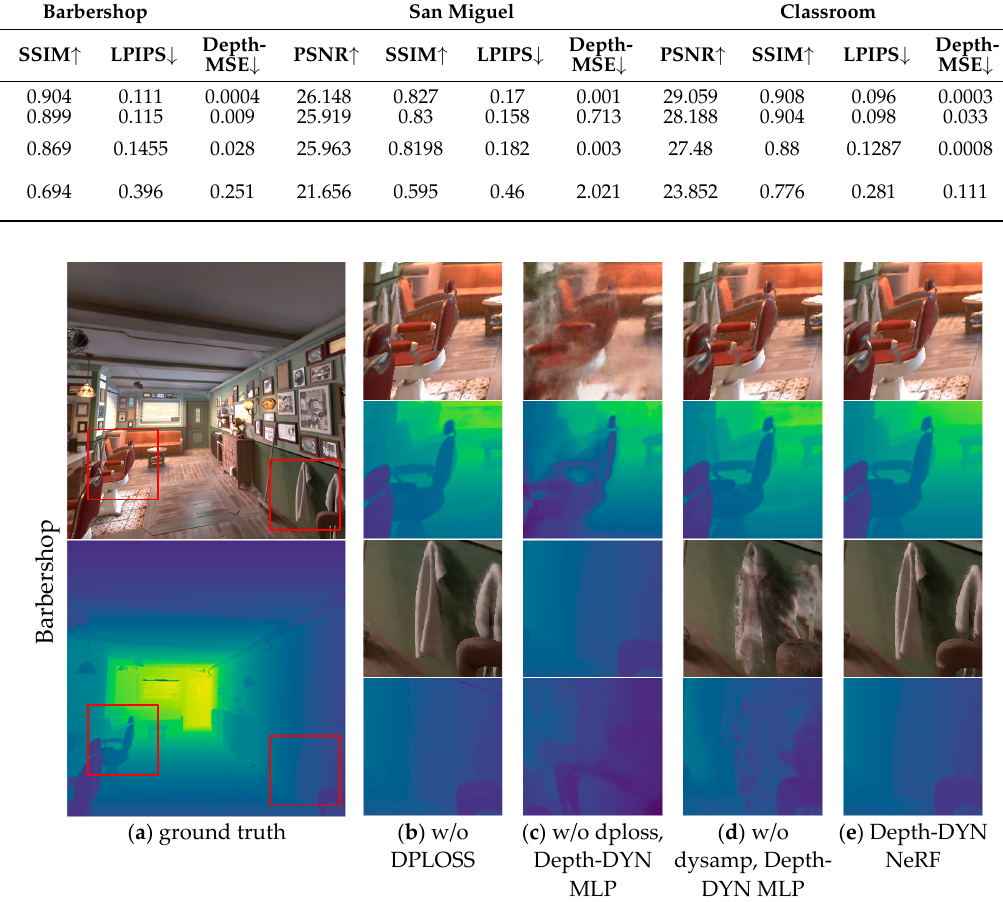
Table 2. Ablation studies performed on our model. The table shows a quantitative comparison of Depth-DYN NeRF without depth loss (w/o DPLOSS), without depth loss and depth MLP (w/o dploss, Depth-DYN MLP), and without dynamic depth and depth MLP (w/o dysamp, Depth-DYN MLP).